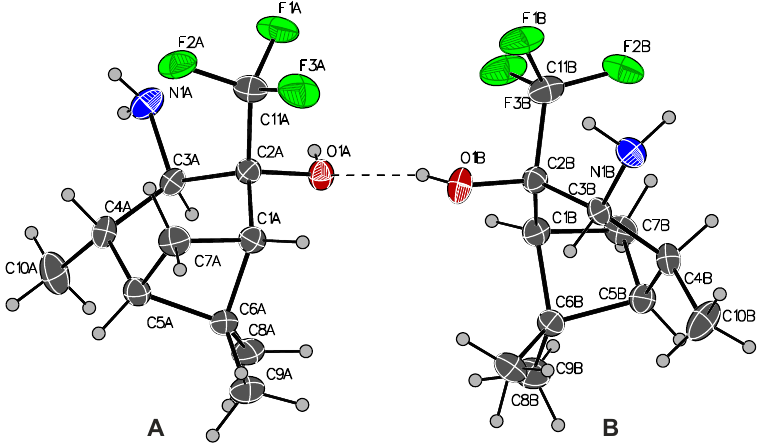
Figure 3. Molecular structure of two independent molecules ( A , B ) of compound 16 with thermal ellipsoids drawn at the 30% probability level.